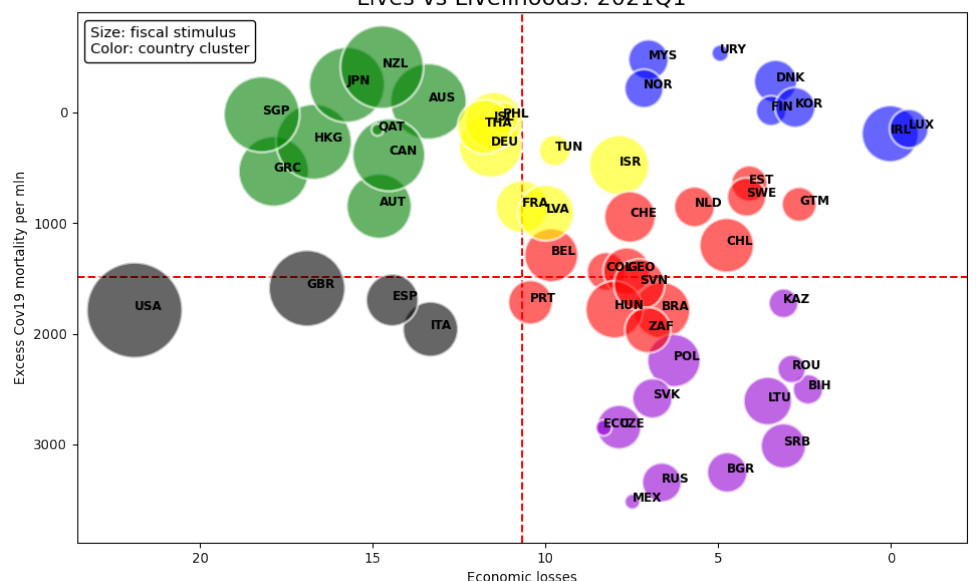
Figure 2. Economic losses ( x -axis) and excess COVID-19 mortality per million people ( y -axis) at 2021Q1. Note: Bubble size reflects countries’ additional fiscal spending compared to before the outbreak. Color groups are based on hierarchical clustering analysis. The red dashed lines are traced at mid